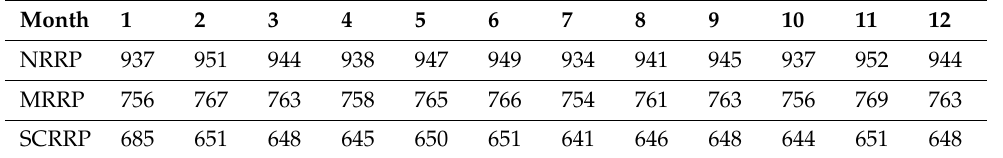
Table 2. Monthly cost with Poisson demand traffic with α =